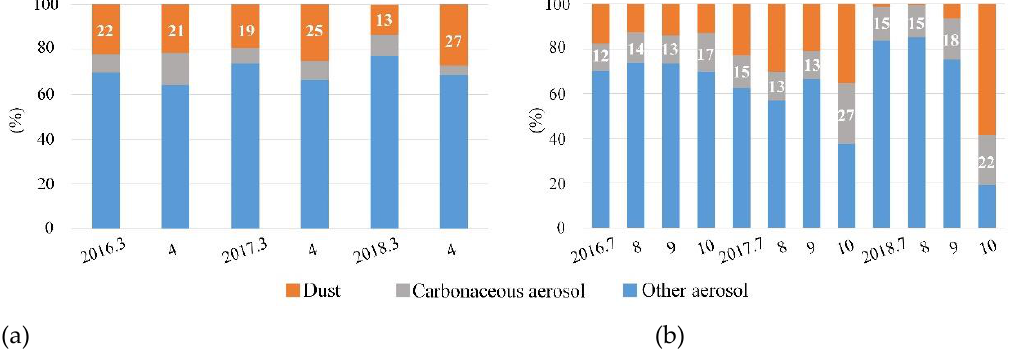
Figure 4. Statistics of the monthly average fraction of relevant absorbing aerosols at the three sites in the selected period. ( a ) The monthly average fraction distribution of dust, carbonaceous aerosol, and other aerosols at the Yonsei University site in March and April each year from 2016 to 2018; ( b ) The monthly average fraction distribution of dust, carbonaceous aerosol, and other aerosols at the Cart site from July to October of each year from 2016 to 2018.